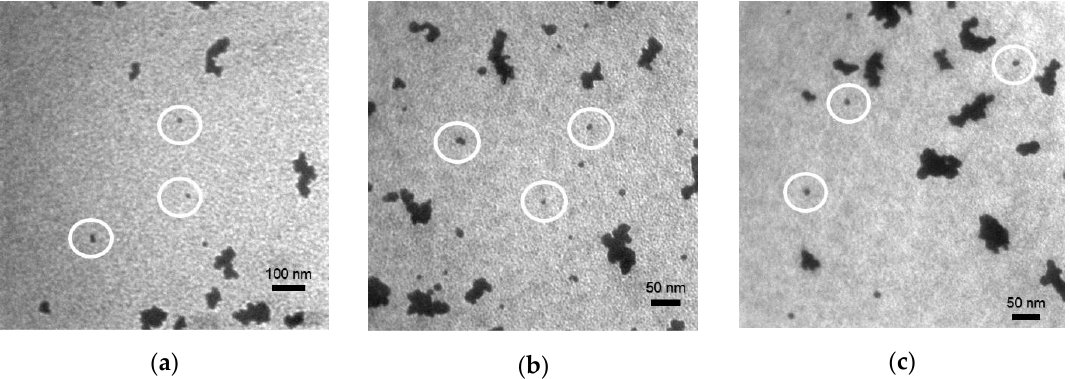
Figure 3. TEM images of ( a ) CCO, ( b ) 5% Mg:CCO, and ( c ) 10% Mg:CCO nanoparticles. Individual and double nanoparticles, as shown inside white circles in ( a ) – ( c ) are used to calculate size distributions shown in Table 2 and Figure 4a.